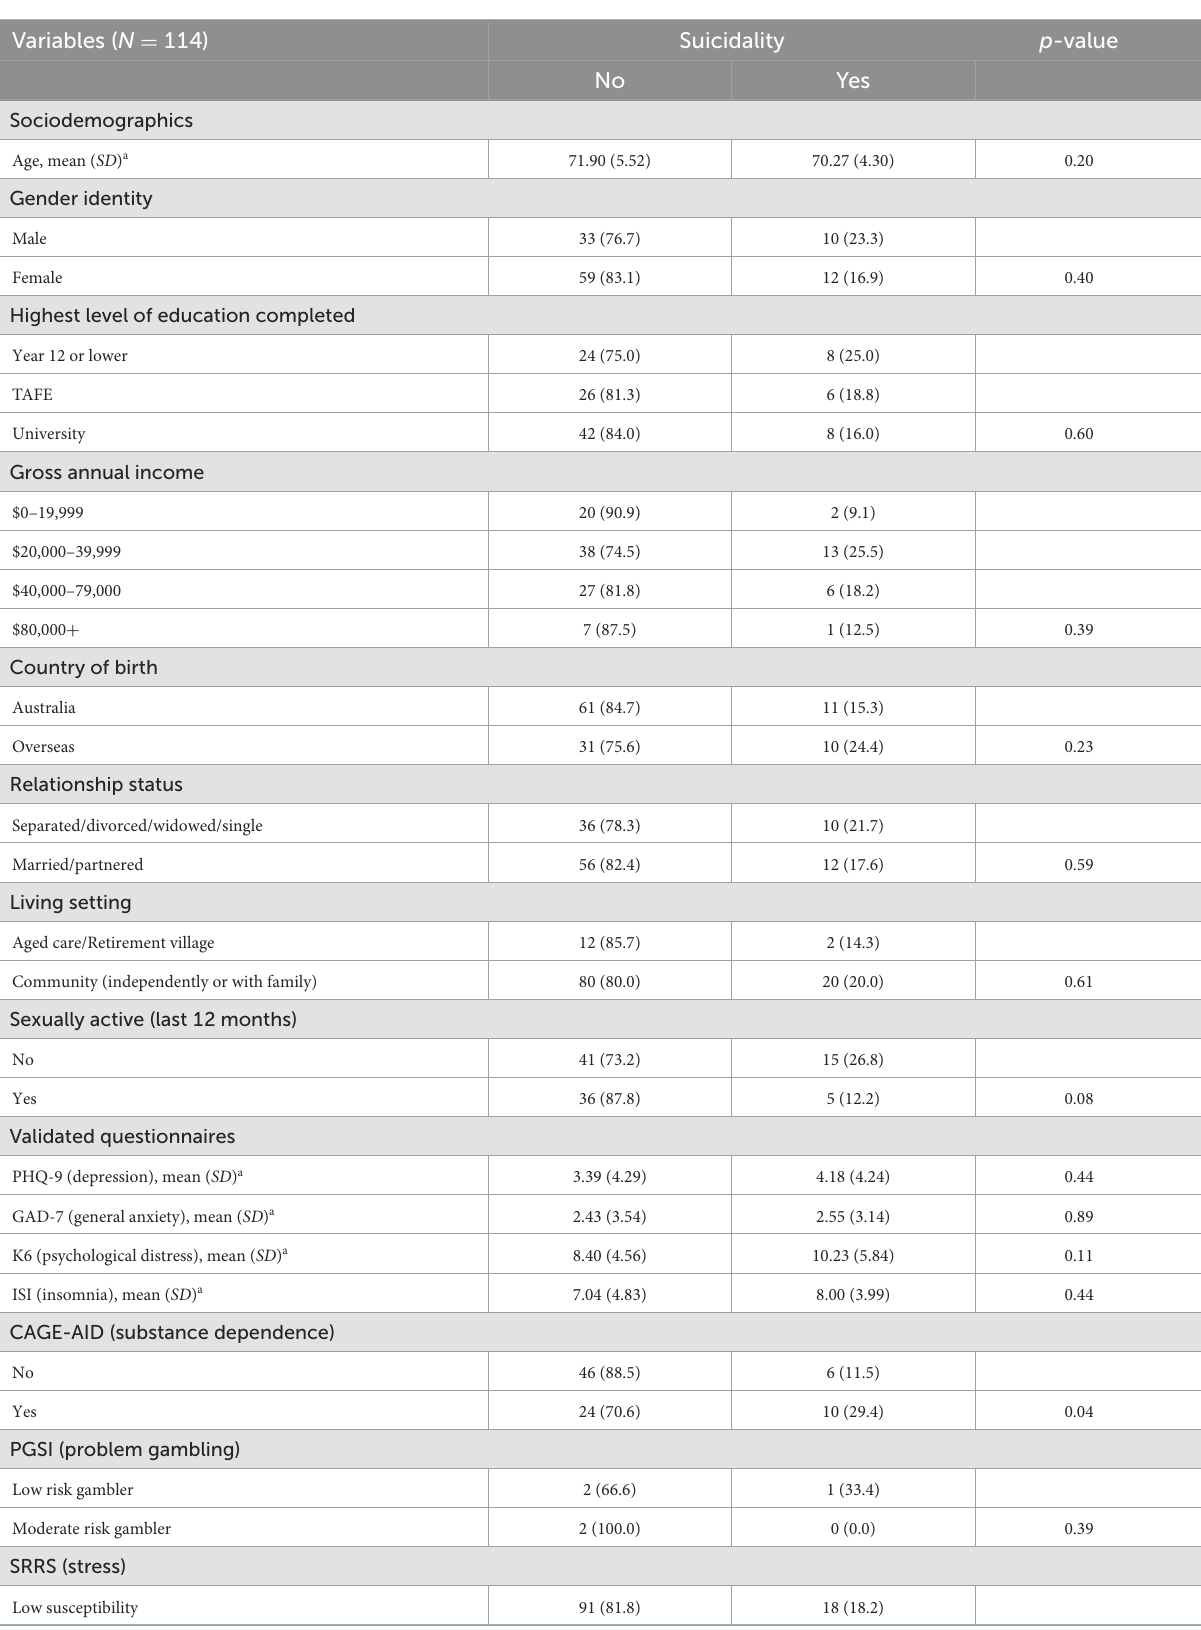
TABLE 2 Suicidality by sociodemographic, validated measures, and mental and physical health and well-being items. Variables ( N =